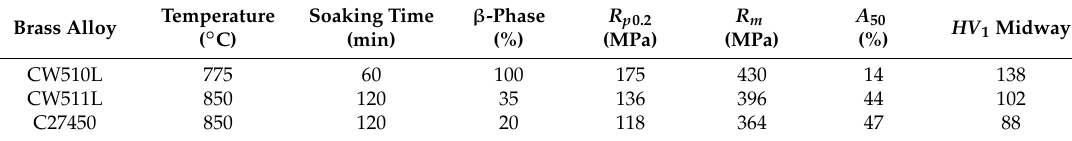
Table 4. Phase structure and mechanical characteristics of heat treated lead-free brass alloys. Brass Alloy